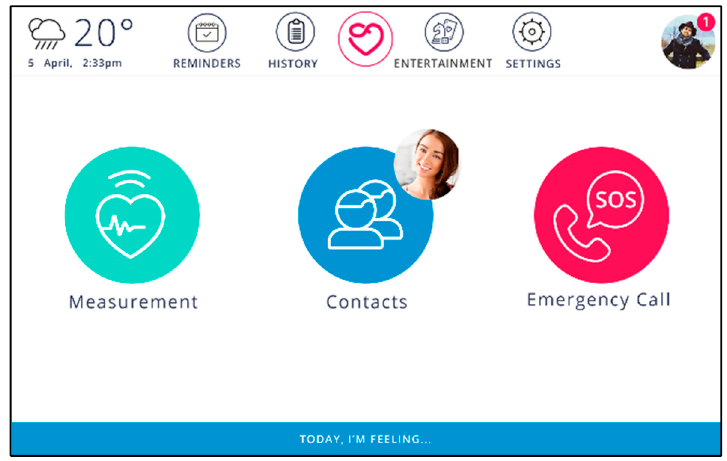
Figure 7. New graphical user interface (GUI)—home screen.